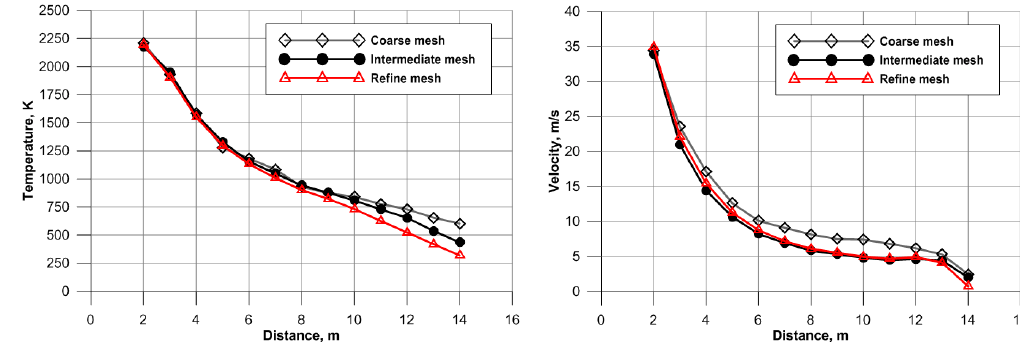
Figure 3. Temperature ( left ) and velocity ( right ) along with the ceiling, for varying mesh resolutions in the covered car park, with a 299.3 g/s hydrogen release through TPRD = 3.34 mm (case 1) at flow time 5.5 s.